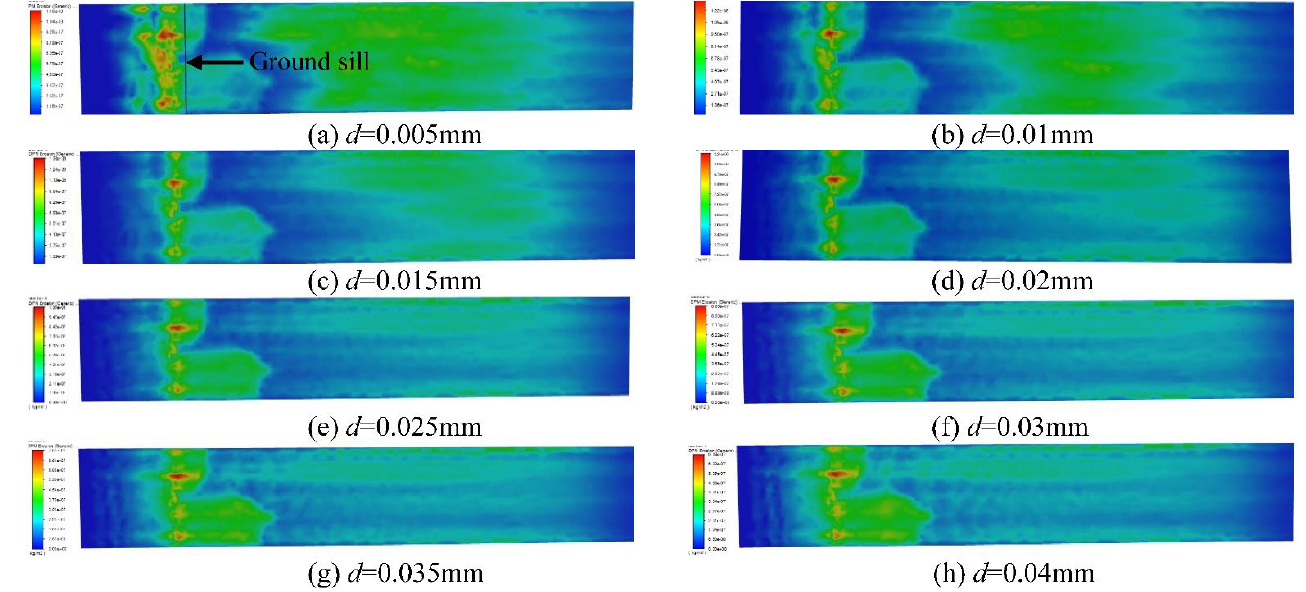
Figure 6. Erosion cloud diagram of spillway bottom under sediment with different diameters.